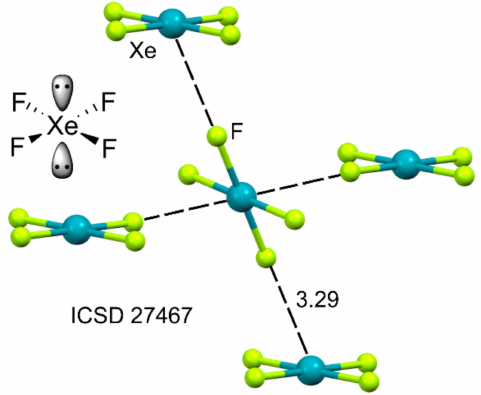
Figure 5. Ball and Stick representation of the X-ray structure of XeF 4 , refcode ICSD-27467. Distance in Å.